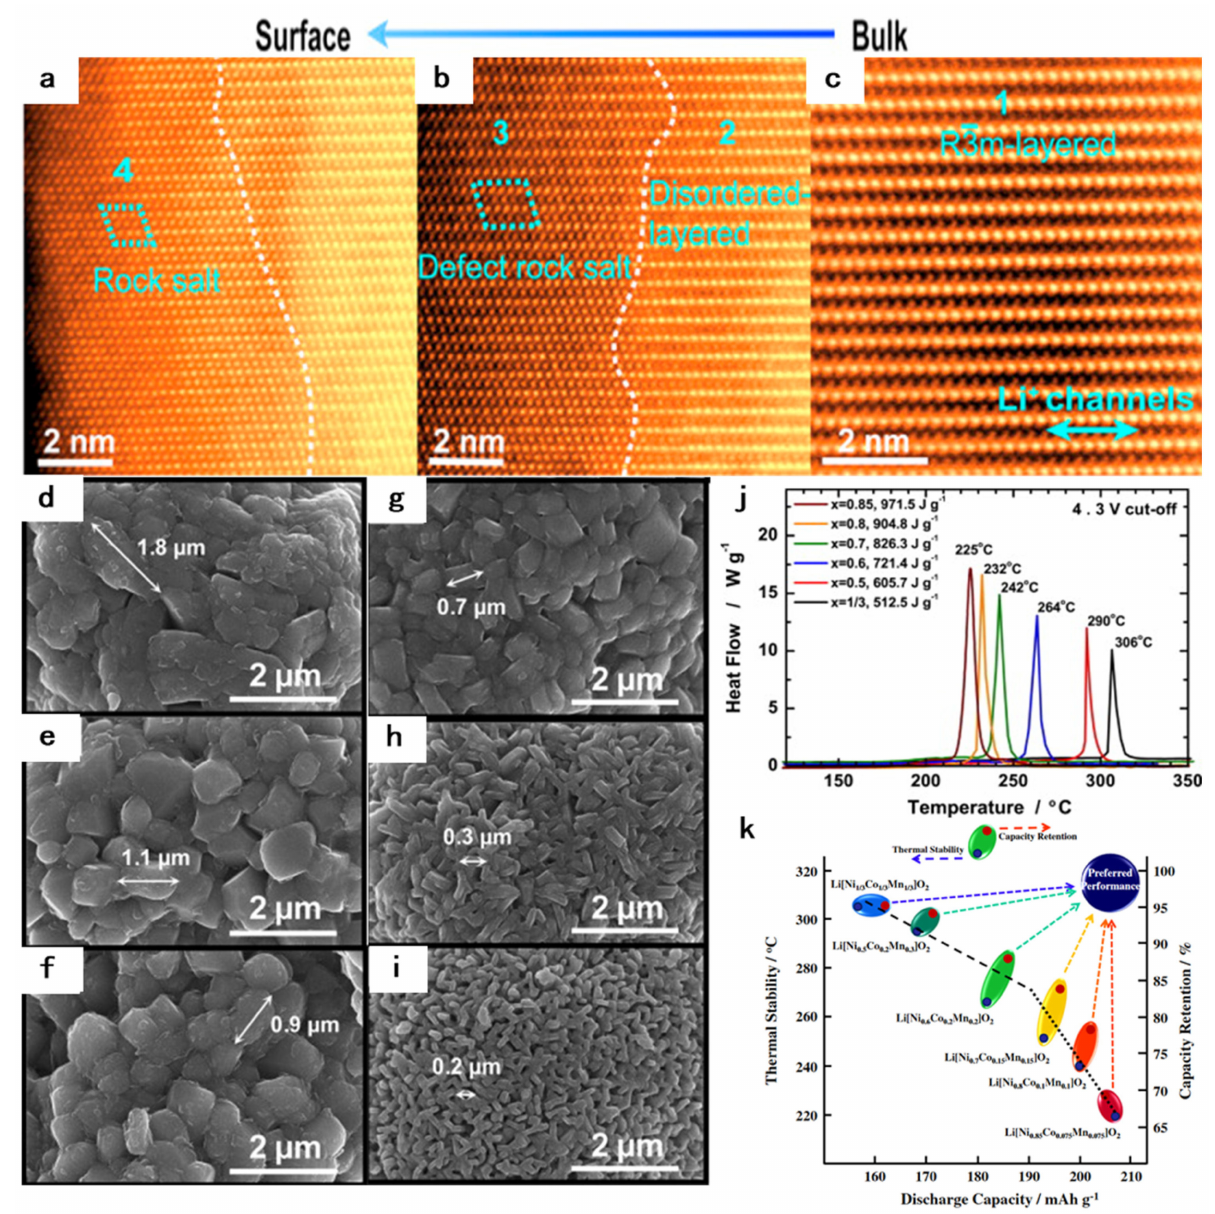
Figure 1. ( a − c ) Atomic-resolution STEM-HAADF and ABF images captured on NMC811 cathode after 100 cycles with cut-off voltage of 4.5V in <010> zone projection. The STEM-HAADF images at different regions from bulk to surface. The white dashed lines denote the surface reconstruction layer at different stages; Reprinted with permission from Ref. [37]. 2018, Elsevier. ( d − i ) SEM images of the Li[Ni x Co y Mn z ]O 2 powders: ( d ) x = 1/3, ( e ) x = 0.5, ( f ) x = 0.6, ( g ) x = 0.7, ( h ) x = 0.8